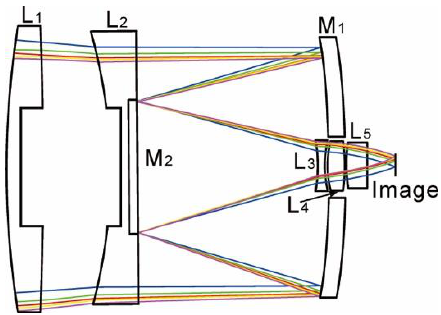
Figure 3. Schematic diagrams of optical system structure after mass reduction.